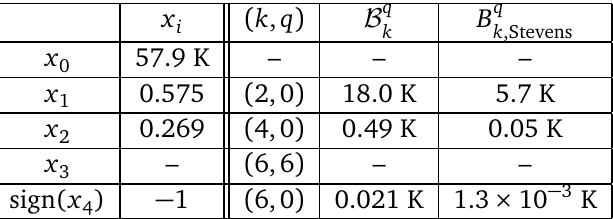
Table 3: Stevens parameters for PrMg